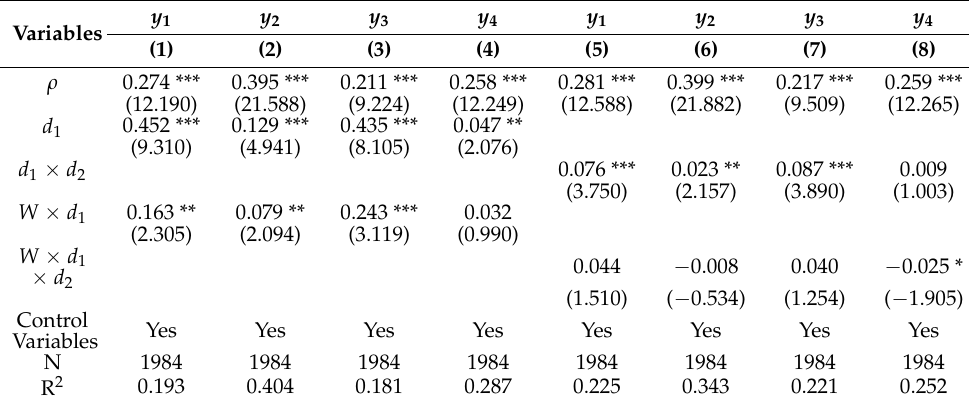
Table 3. Results of the static spatial econometric